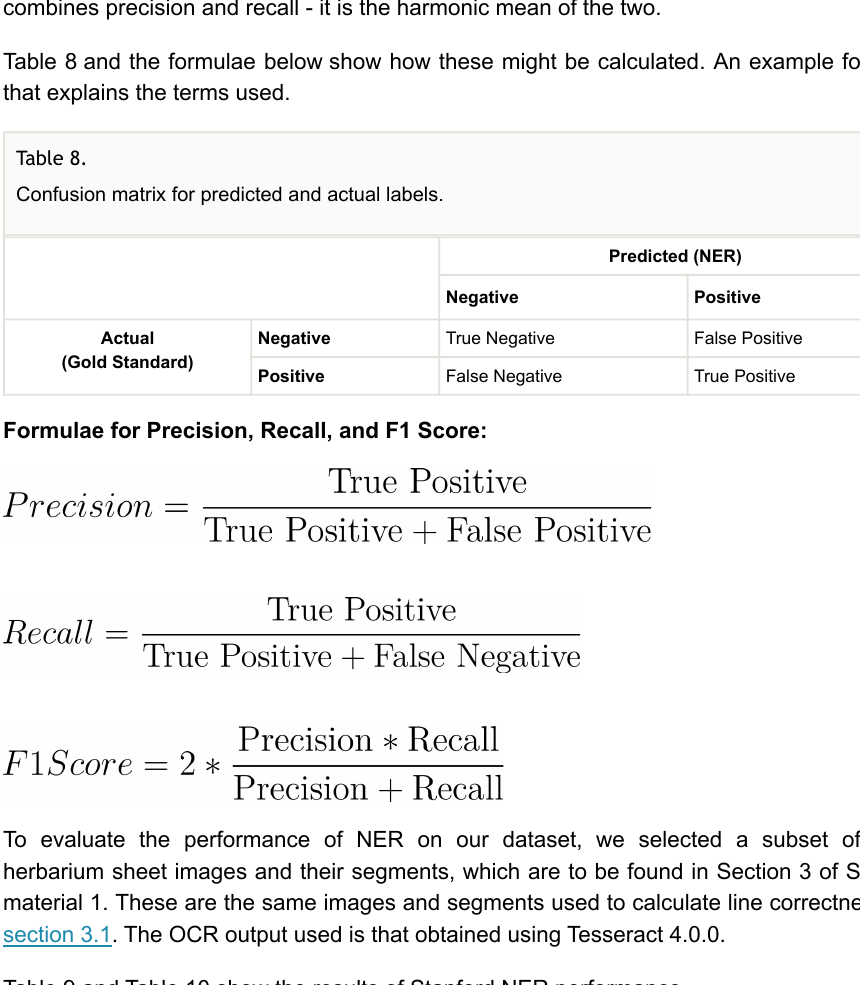
Table 9 and Table 10 show the results of Stanford NER performance. Table 9. NER performance on OCR text retrieved from whole